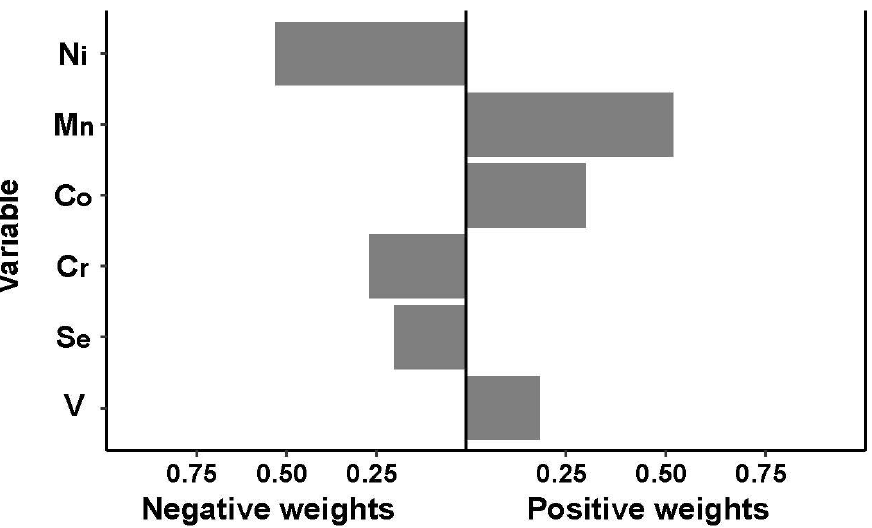
Figure 2. Association between trace element levels and GDM based on quantile g-computation analyses. The estimated weights of each element in the mixture were presented by bootstrapping in either direction.